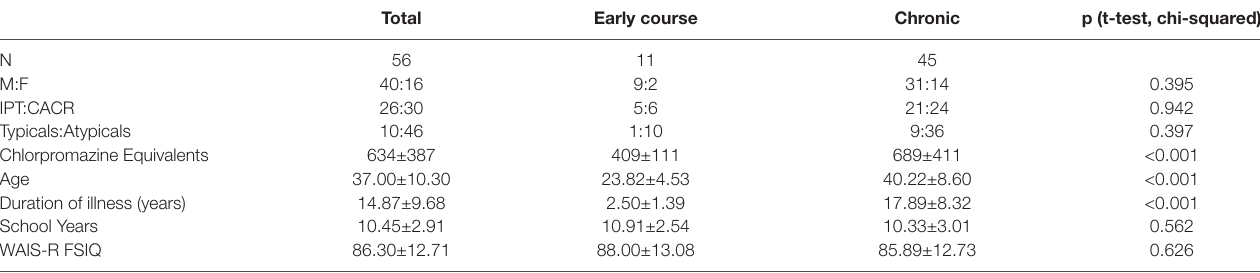
TABLE 1 | Demographic variables of the